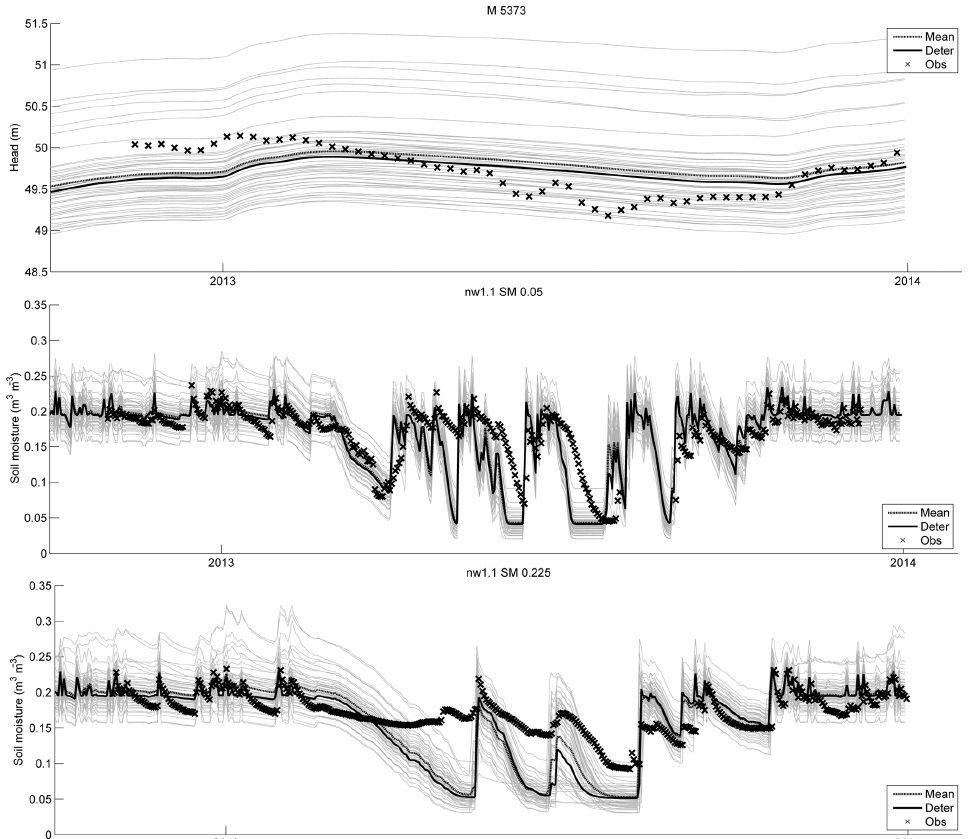
Figure 7. Top: groundwater head at well M5373. Middle: soil moisture at 2.5cm at site nw1.1. Bottom: soil moisture at 22.5cm depth at site nw1.1. The light grey lines (not marked in the legend) are the open-loop ensemble prediction. “Mean” (single grey line) is the ensemble average. “Deter” (dark line) is the deterministic model. “Obs” (cross marks) are the observations.